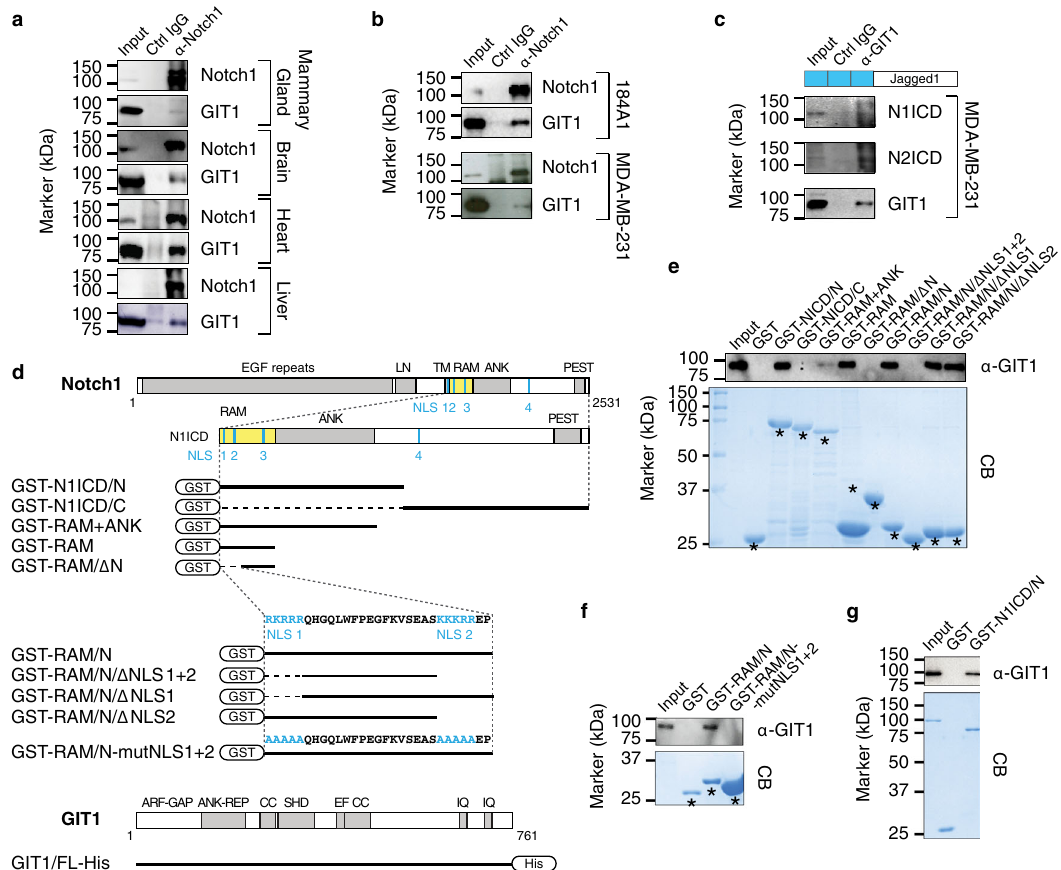
Fig. 3 GIT1 directly binds to the Notch intracellular domain. a , b Co-IP of GIT1 with Notch1 from lysates of the indicated mouse organs ( a ) and human breast cell lines ( b ). c Co-IP of the Notch1-2 ICDs with GIT1 from lysates of the MDA-MB-231 cells treated as indicated. d , Schematic diagrams of recombinant fusion protein fragments. e , f GIT1 pulled down by GST Notch fragments from MDA-MB-231 cell lysates. g Pulldown of puri fi ed GIT1-His by puri fi ed GST-N1ICD/N. CB, Coomassie Blue. Images from representative blots; the experiment was repeated n = 3 times with similar results. *, indicates recombinant GST-fused peptides. Source data are provided as a Source Data fi